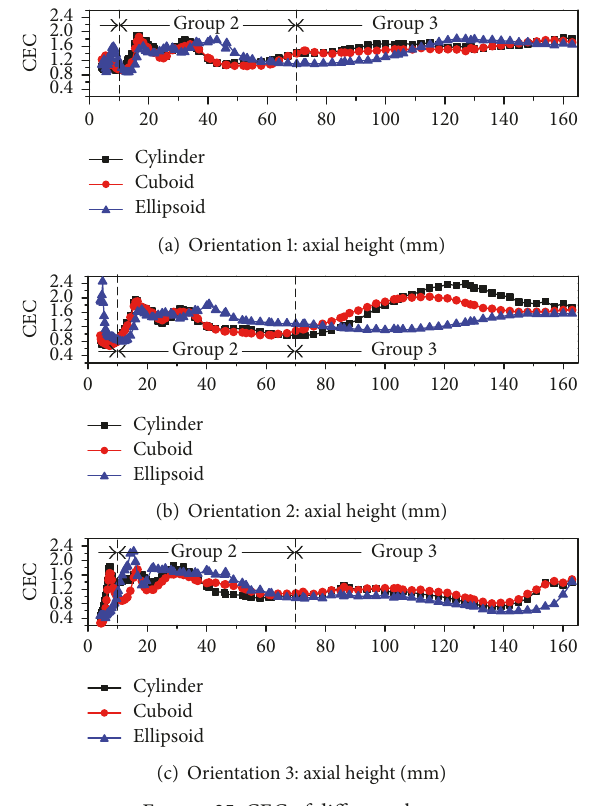
Figure 25: CEC of different